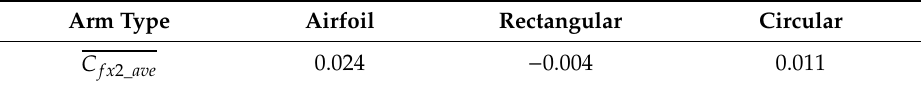
Table 5. Friction-based tangential force coefficients averaged along the arm span direction.